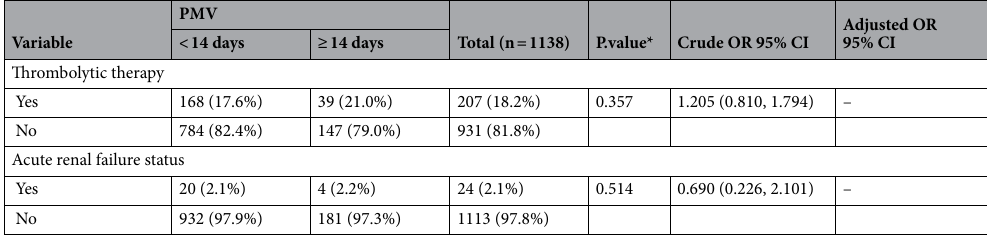
Table 2. Characteristics participants and logestic regression (univariate and multivarieate) for PMV > 14. PMV prolonged mechanical ventilation, OR odds ratio, IQR interquartile range, FiO 2 fraction of inspired oxygen, PaO 2 partial pressure of oxygen, PaCO 2 partial pressure of carbon dioxide, pH potential of hydrogen, GCS Glasgow Coma Scale. Significant values are in [bold]. *P.value ≤